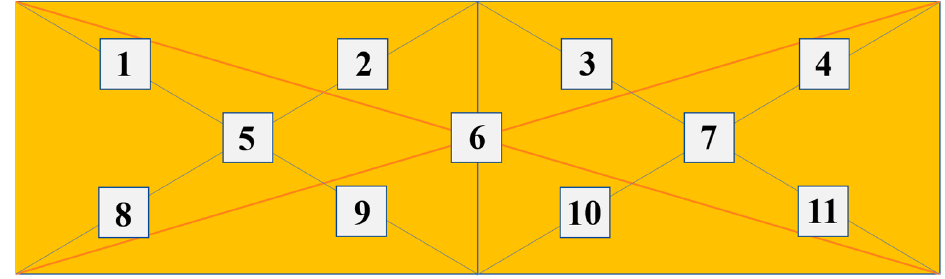
Figure 9. Model diagram of the sampling method.